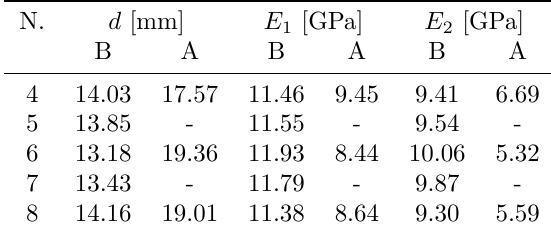
Table 1. Pilodyn 6J indentation